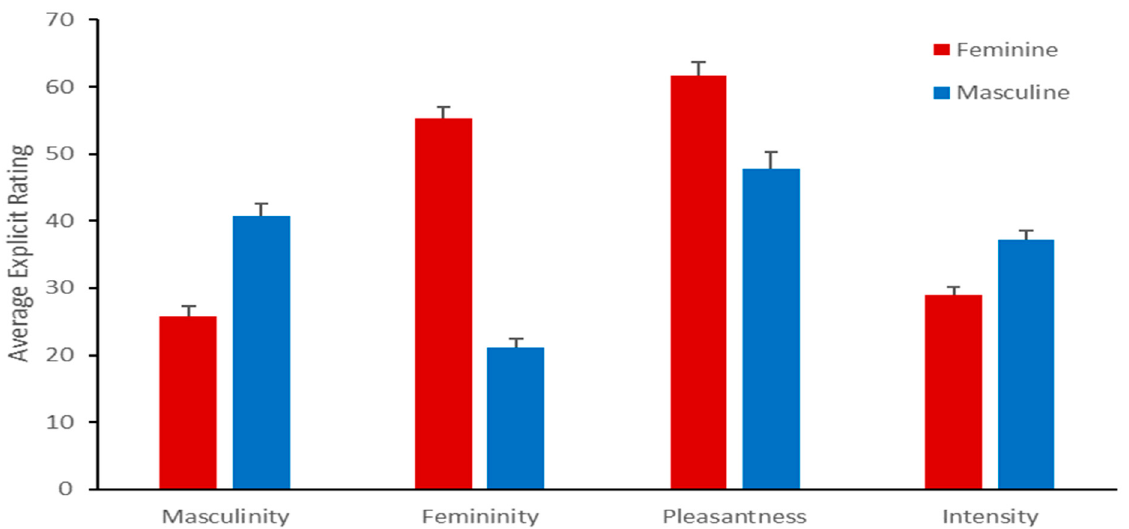
Figure 2. Figure depicts the mean explicit VAS or gLMS ratings of odorants selected a priori to be semantically masculine and feminine, with the error bars showing the standard error of the mean. All ratings were normalized to be on a 0–100 scale (pleasantness was actually rated from − 100 to